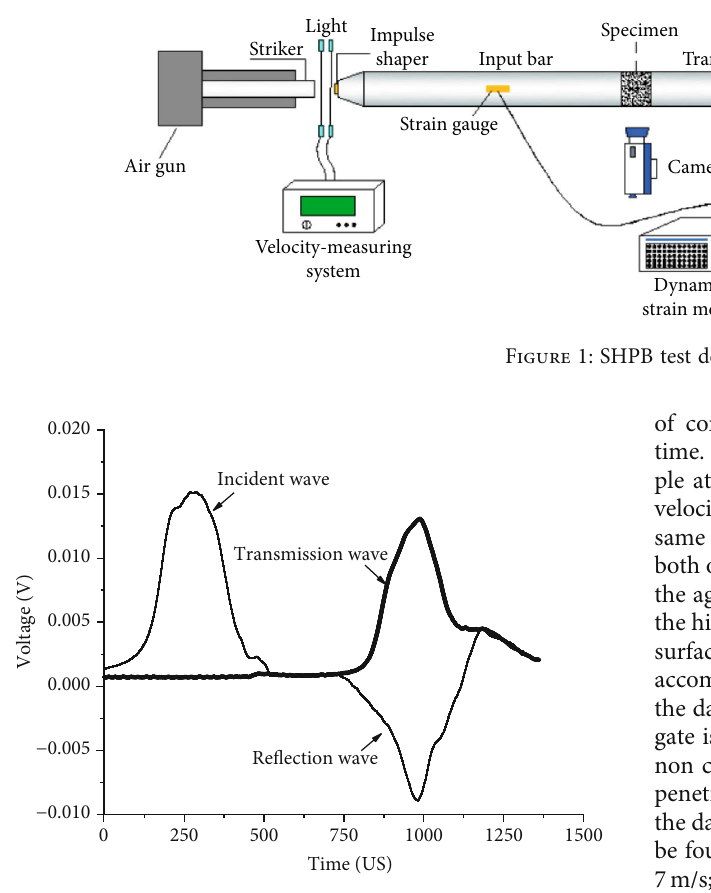
Figure 2: Primitive waveform in the SHPB